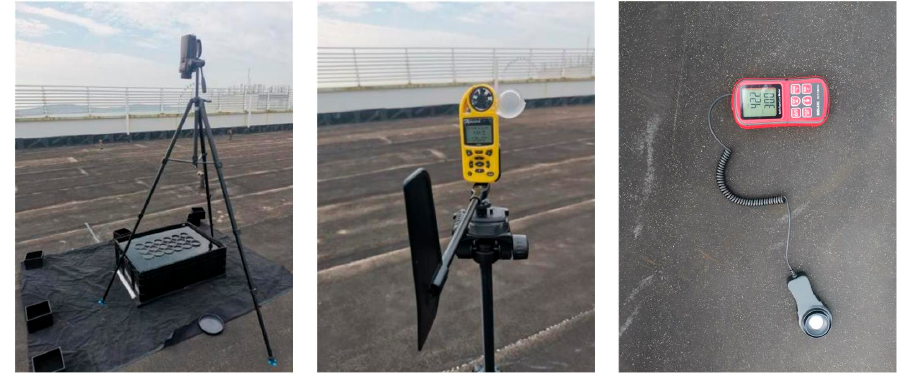
Figure 2. Experimental site diagram.